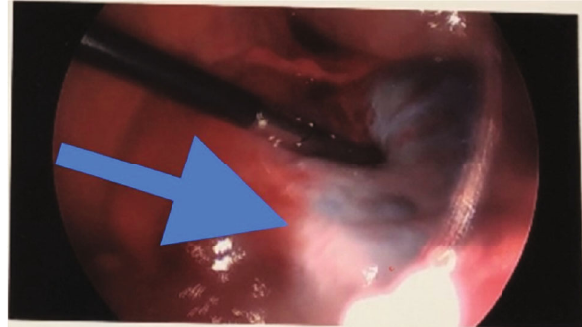
Figure 6: Intraoperative view showing reperfusion (blue arrow) after detorsion of infundibulopelvic and utero-ovarian